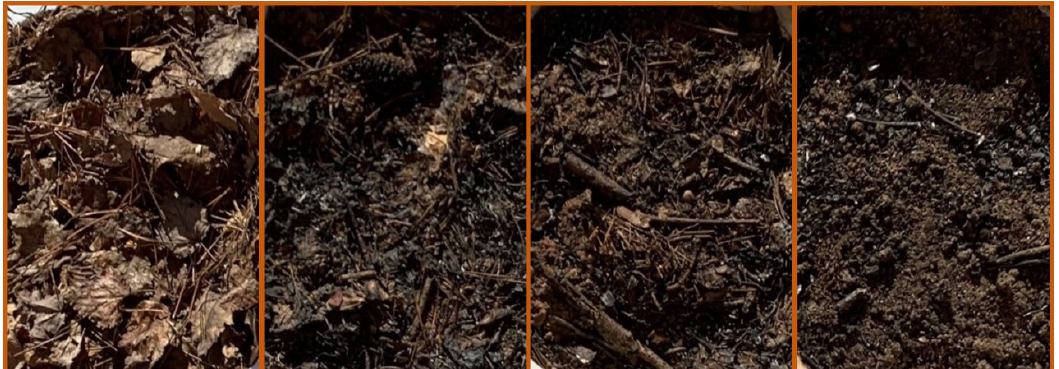
Figure 1. Image of the four experimental treatments. Left to right: unburned control; level 1 = low severity; level 2 = moderate severity; level 3 = high severity. There were 4 replicates of each treatment (n = 16).